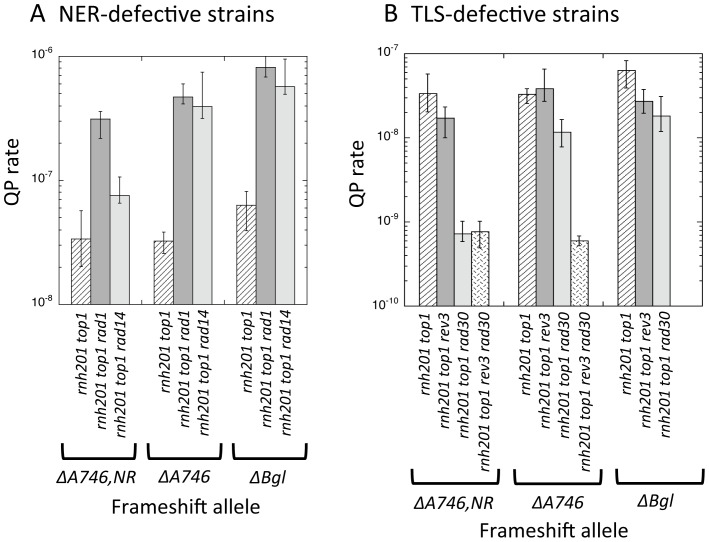
Rates of QP mutations and tandem-repeat deletions at hotspots in NER- or TLS-defective strains.
A. QP mutation rates in rnh201Δ top1Δ strains that are additionally missing the Rad14 or Rad1 component of NER. B. QP mutation rates in rnh201Δ top1Δ strains that are missing Pol ζ (rev3Δ) and/or Pol η (rad30Δ).